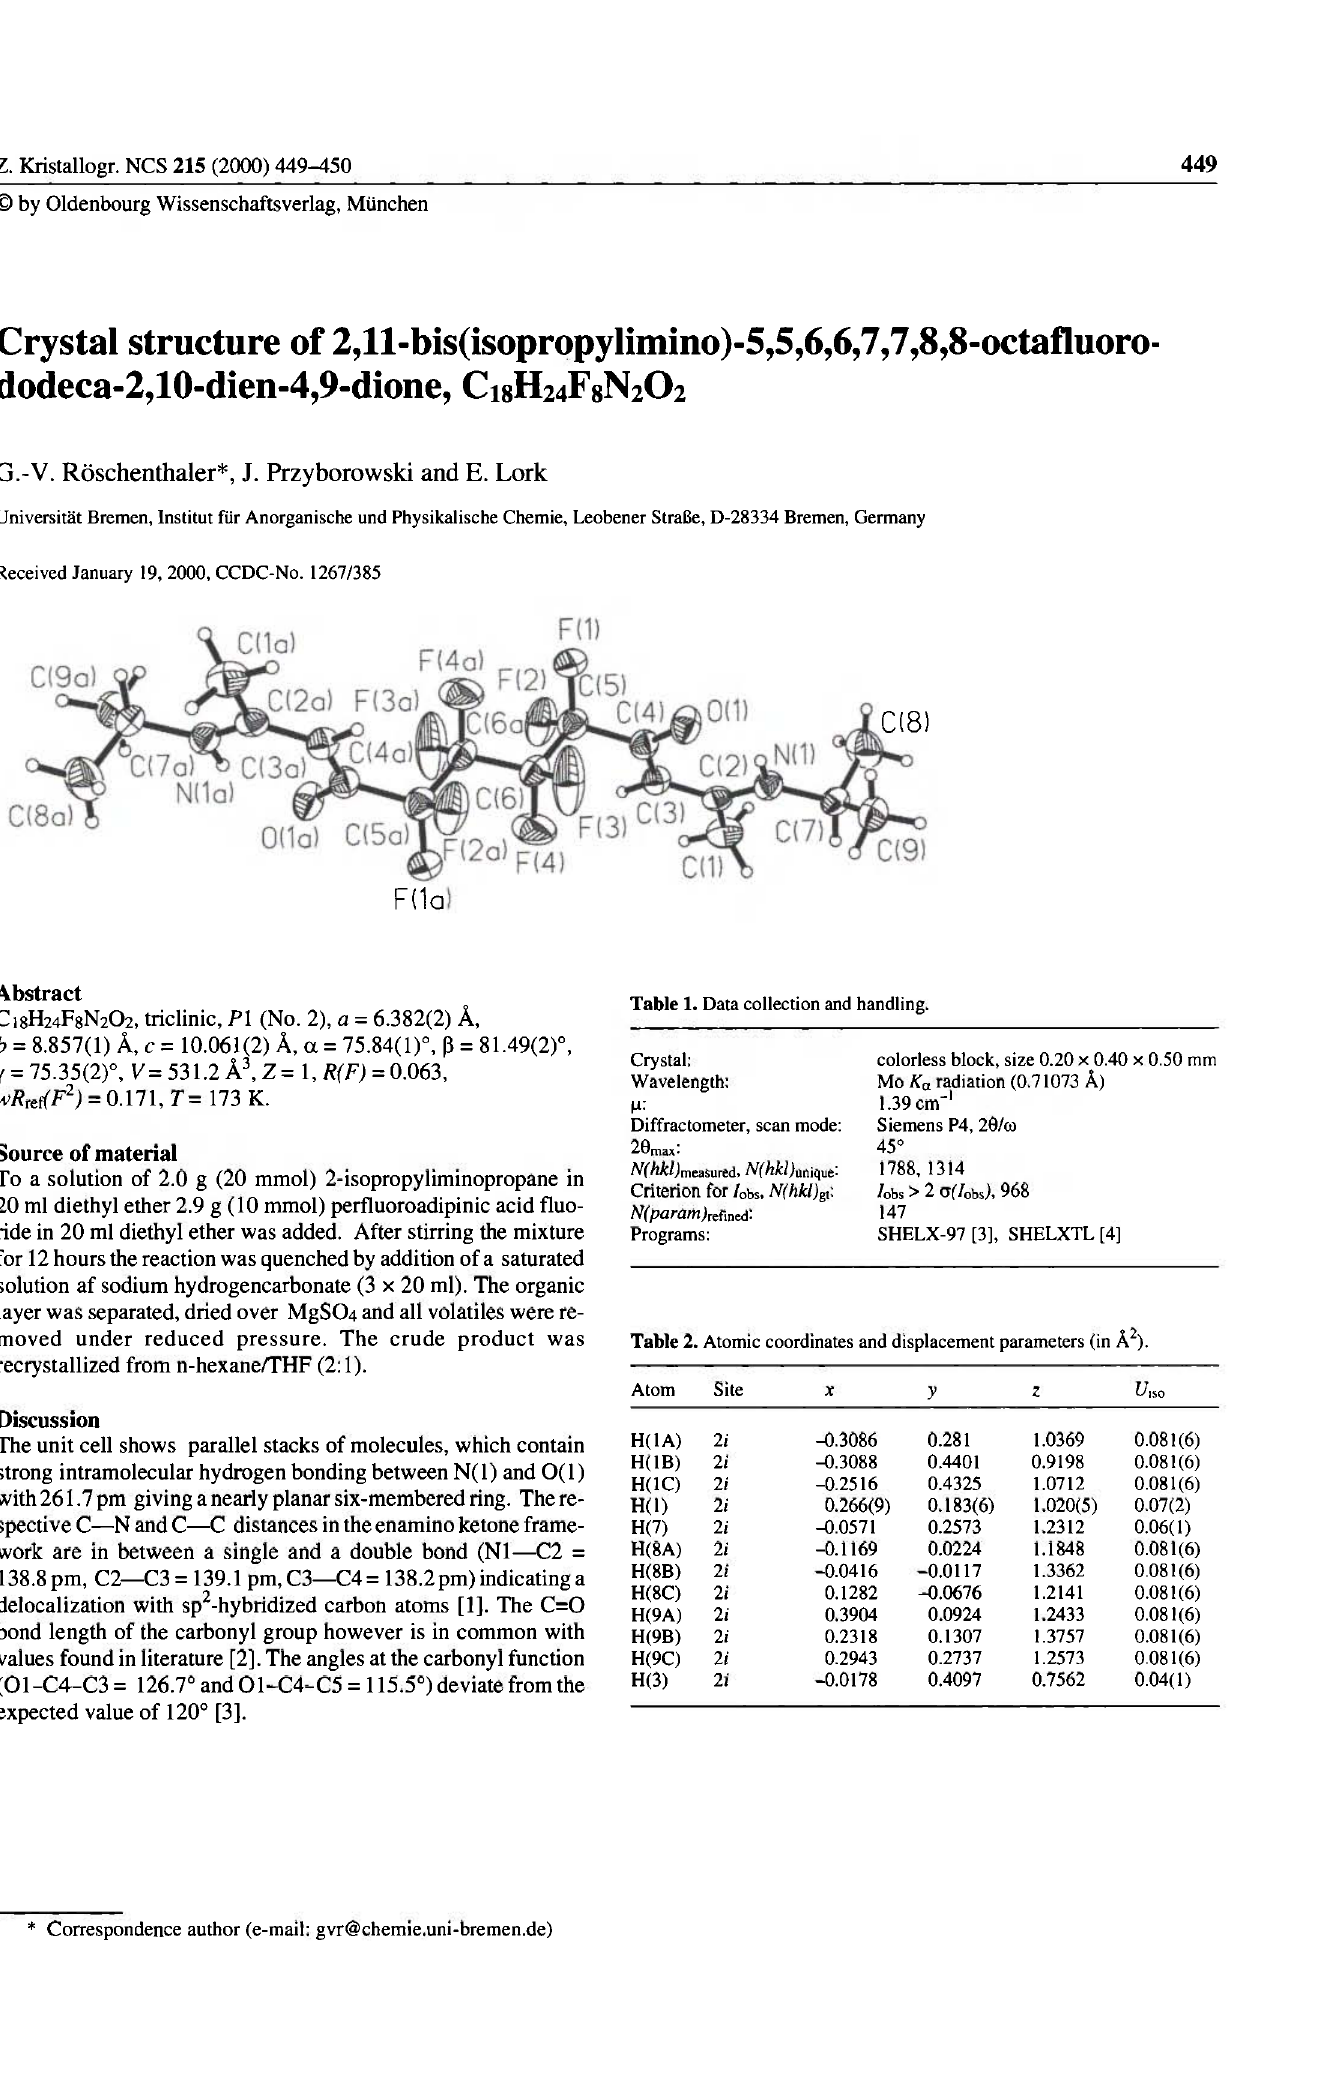
Table 2. Atomic coordinates and displacement parameters (in Ä 2